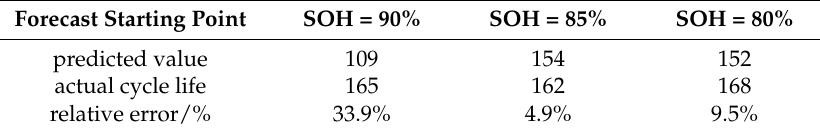
Table 3. Probability prediction results of No. 4 lithium battery cycle life.